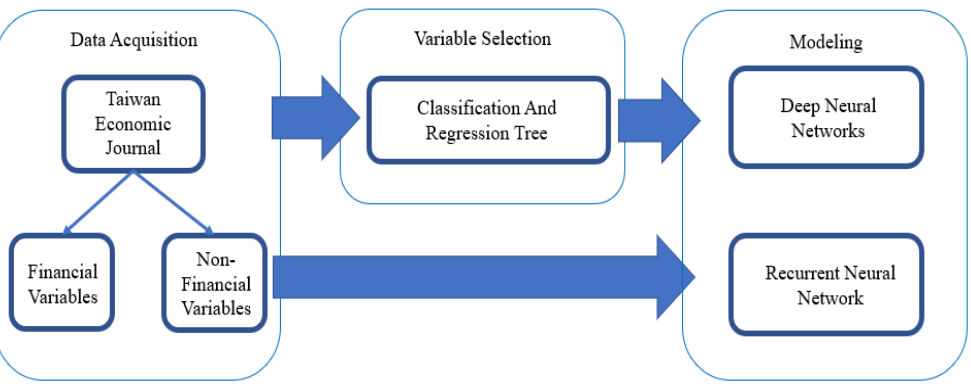
Figure 5. Research Figure 5. Research procedures.